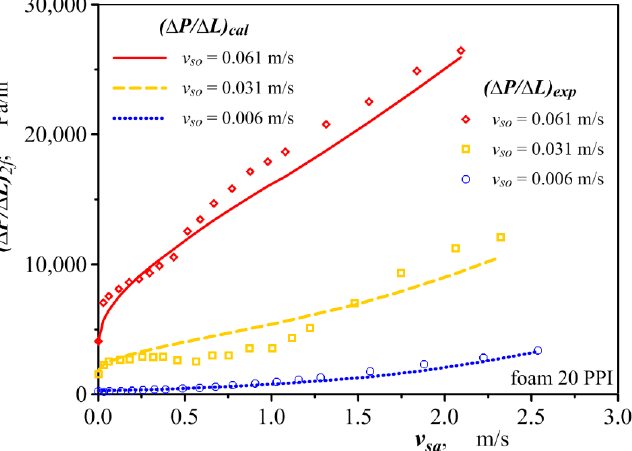
Figure 18. Pressure drop changes in the air–oil flow calculated with the developed pressure drop model.